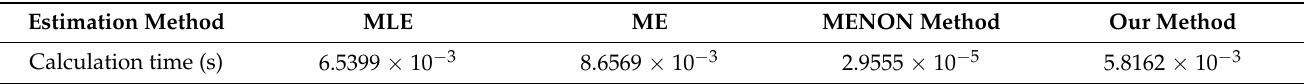
Table 10. The calculation time in simulated Weibull distribution ( k =